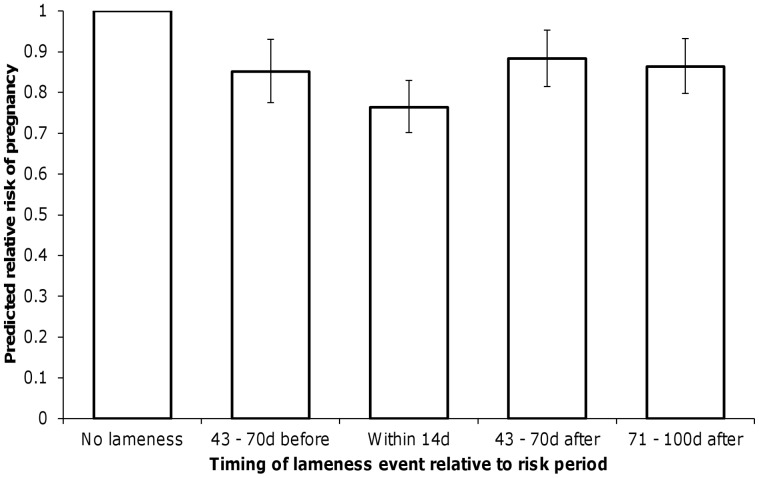
Association between predicted relative risk of pregnancy at a given risk period and clinical lameness.Error bars represent the 95% credible interval for each predicted relative risk.